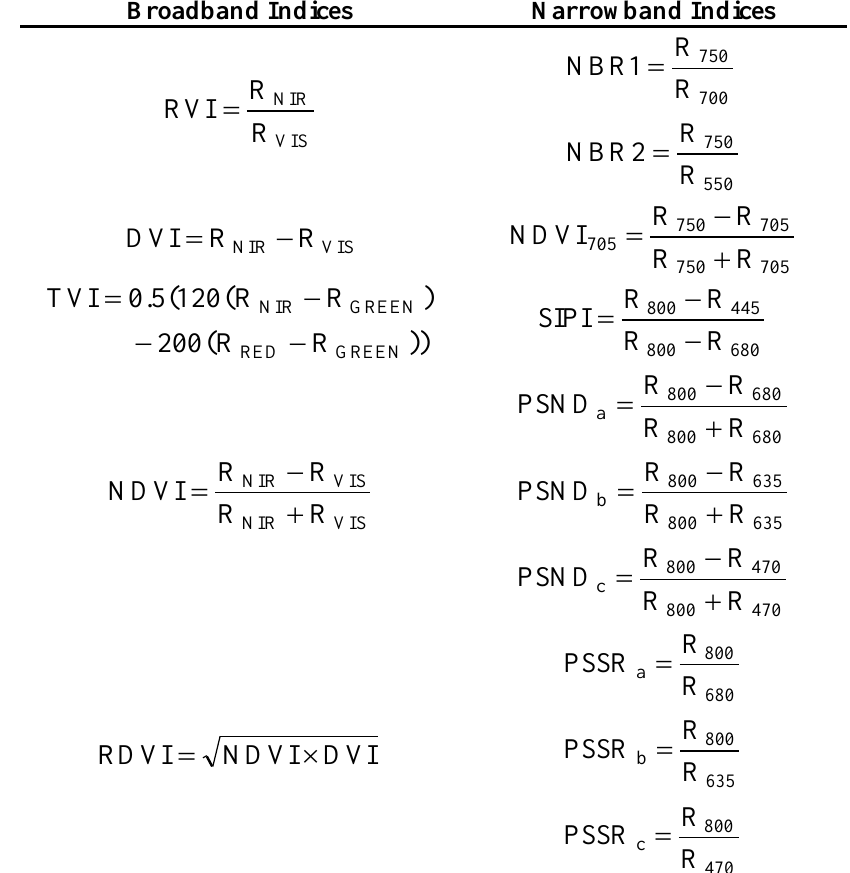
Table 1. Broadband and narrowband vegetation indices. R refers to reflectance and the subscripts refer to specific spectral bands or